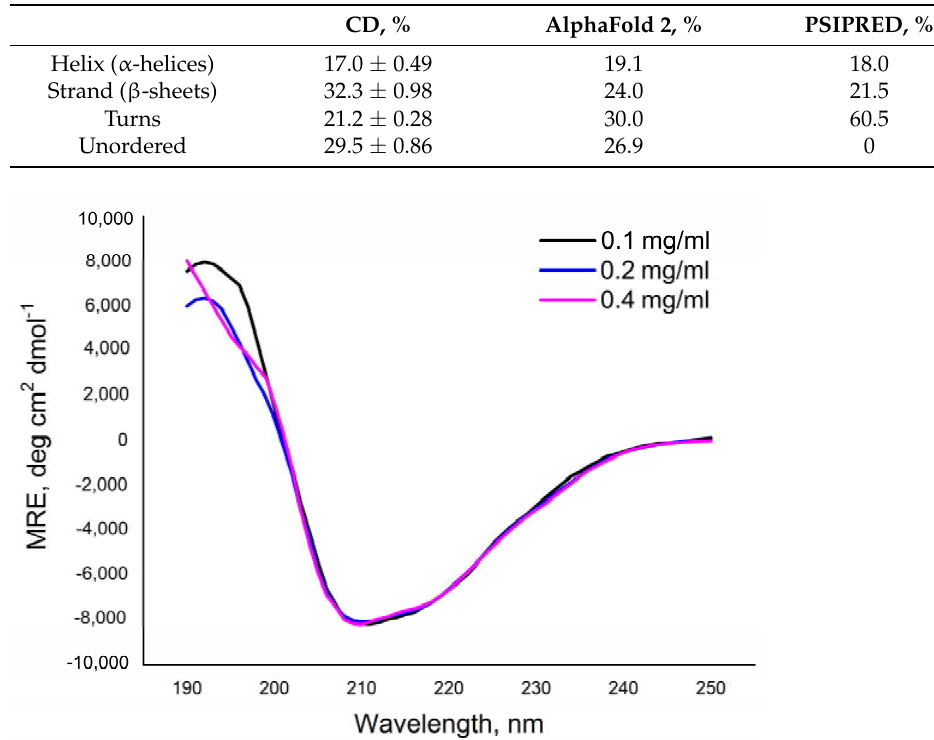
Figure 5. The circular dichroism spectra of the Svx protein of Pectobacterium atrosepticum in 10 mM Tris-HCl buffer (pH